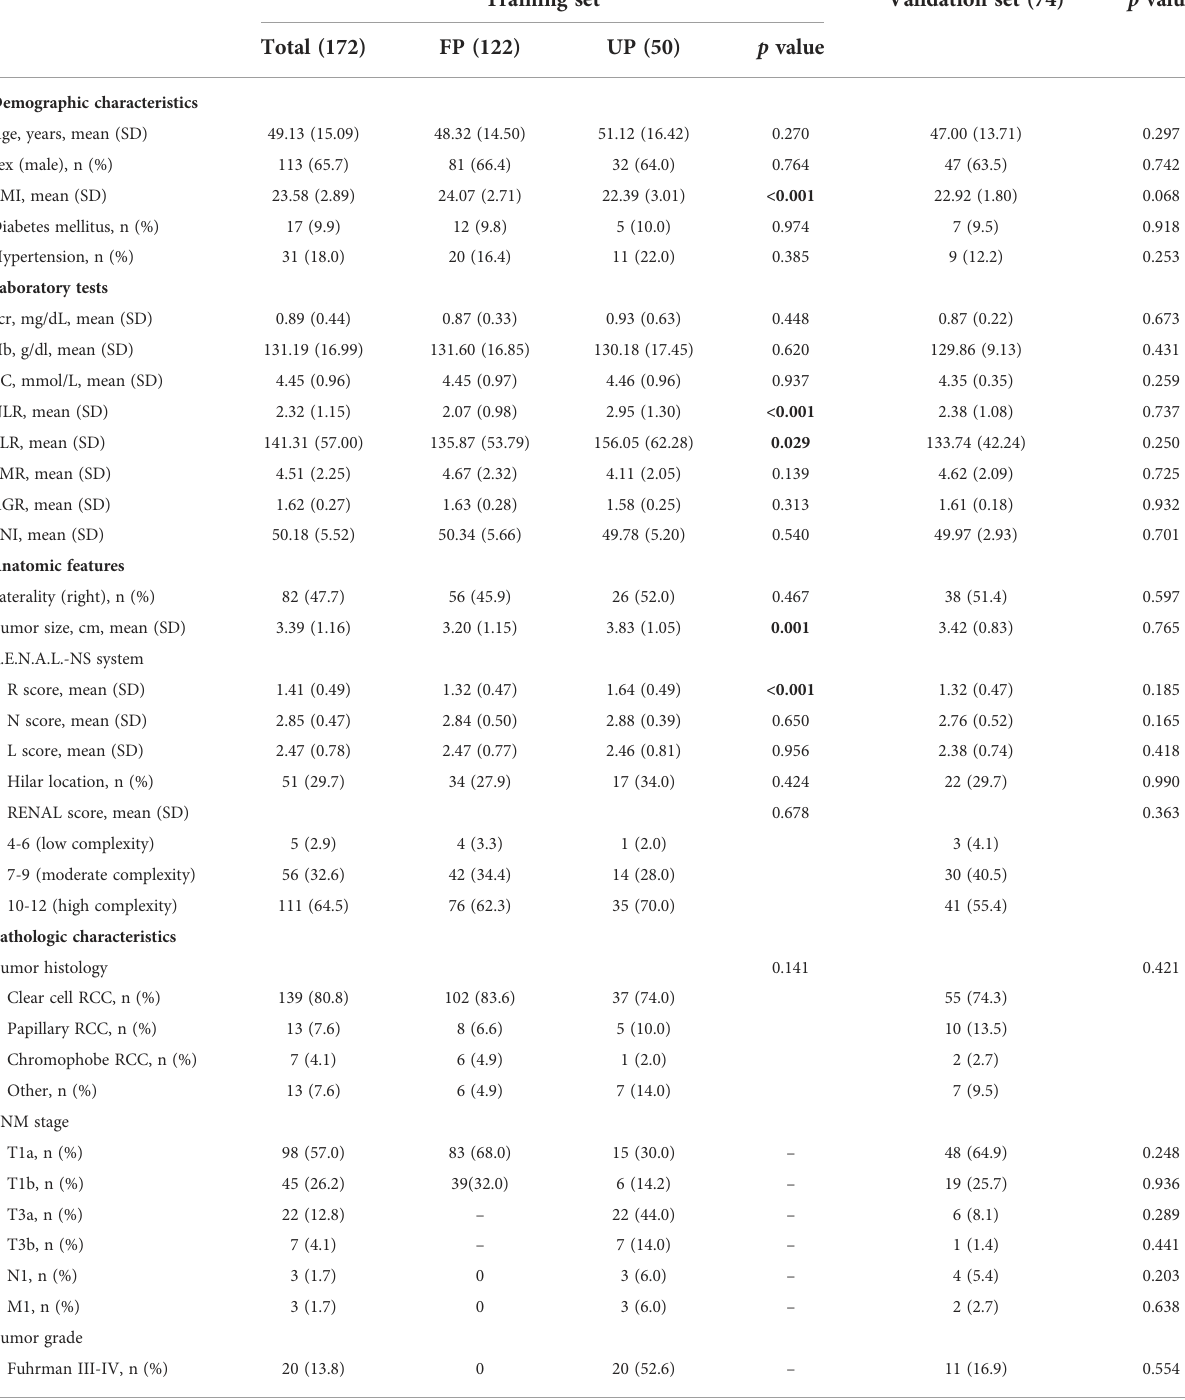
TABLE 2 Demographic and clinical characteristics of the training and validation sets in FP vs. UP